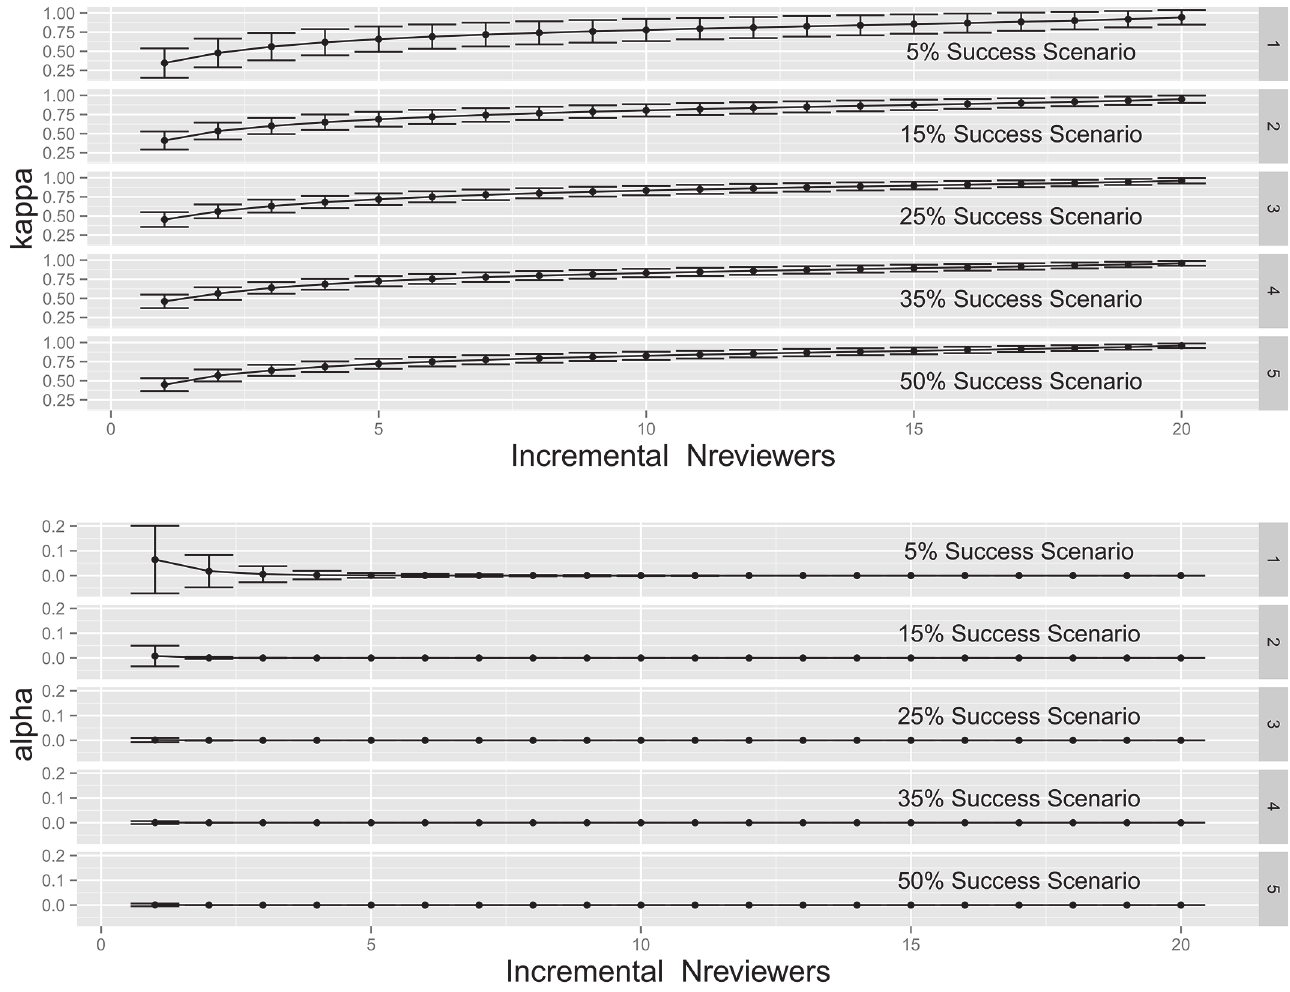
Fig 4. Bootstrapped kappa statistics of peer review decision consistency with incremental N to N+1 reviewers. In simulation of CIHR Fellowships competition outcomes, overall decision consistency improved with incremental addition of reviewers regardless of overall success rate scenario. Monte Carlo error analysis (standard deviation of bootstrapped estimates of kappa coefficients) [33] indicated broad overlap among incremental kappa values with increased reviewers. Kappa levels > 0.8 represented “ almost perfect ” consistency [32]. Kappa values were significant ( α < 0.05) except in the 5% success scenario at the 1 – 2 and 2 – 3 reviewer